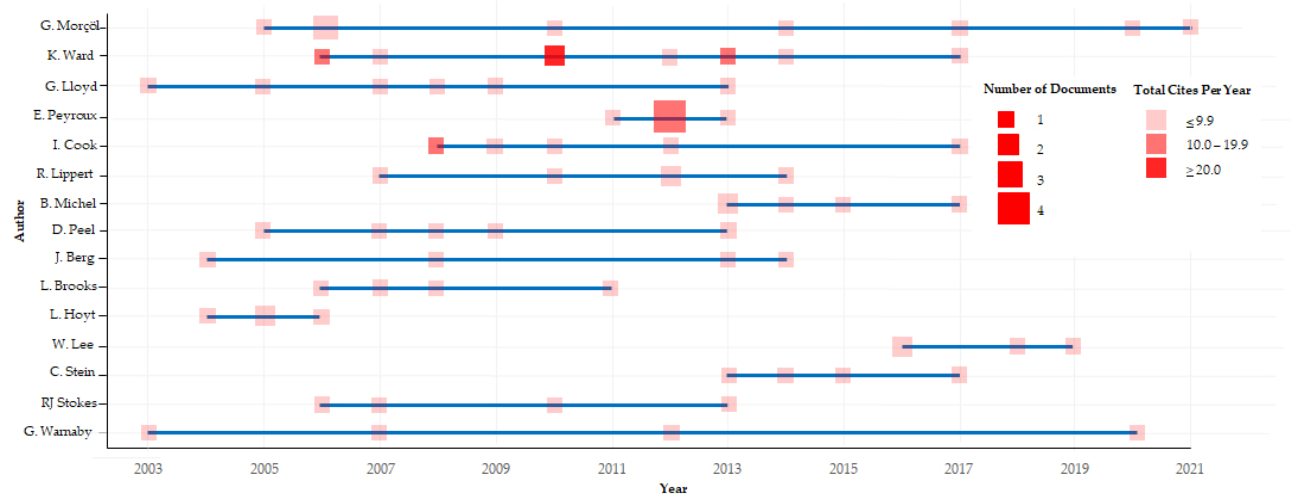
Figure 4. Longitudinal overview of the annual production of academics who published the most on BIDs, 1979–2021.